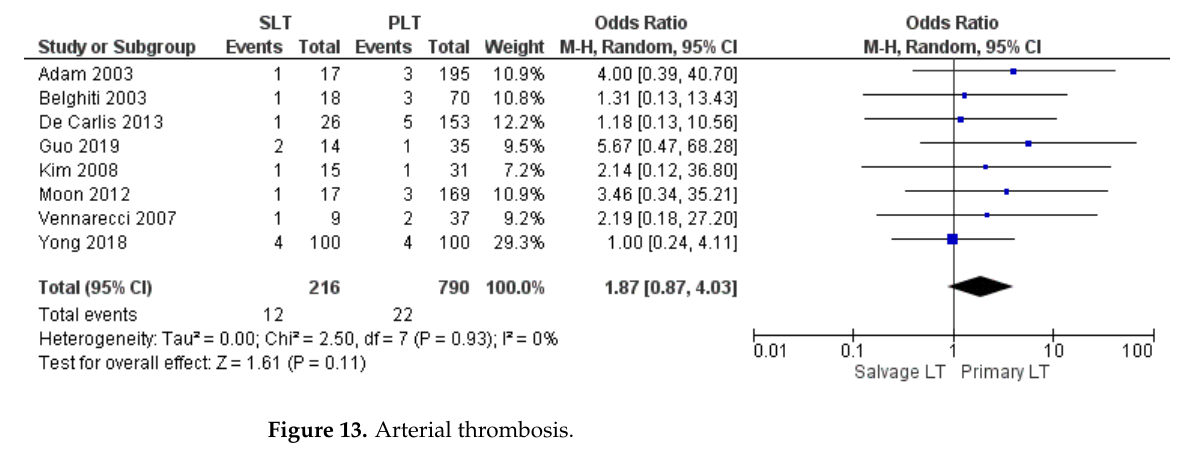
11 of 22 Figure 12. Overall vascular complication.